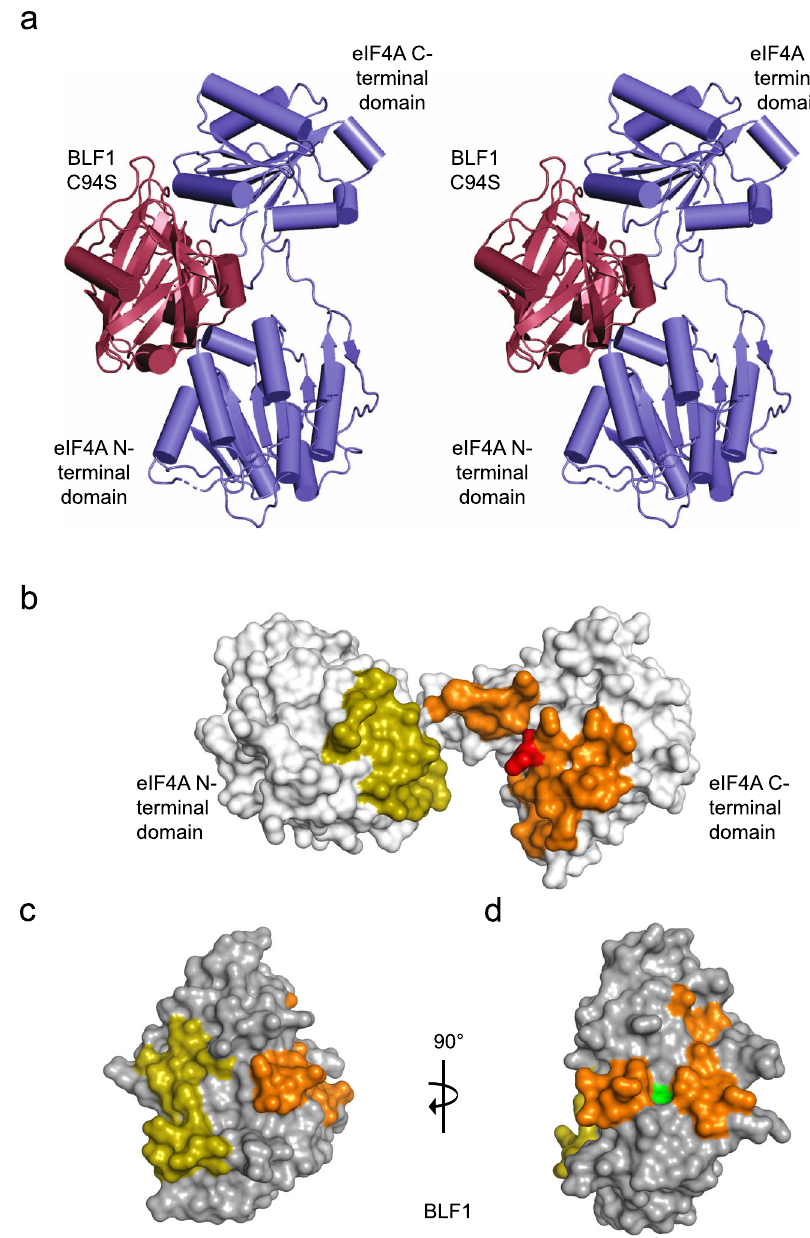
Fig. 1 BLF1 C94S binds in the cleft between the two domains of eIF4A Δ 20 . a Stereo pair for cross-eyed viewing of the structure of the BLF1 C94S:eIF4A Δ 20 complex (PDB:7PQ0 (BLF1; maroon, eIF4A; blue)). b Surface representation of the N- and C-terminal domains of eIF4A. The two patches that interact with BLF1 C94S are shown in gold and orange, respectively with the remainder of the surface colored white. Gln339 of eIF4A is colored red. c Surface representation of the corresponding patches (gold and orange) on BLF1 that interact with eIF4A with the remainder of the surface colored gray. The view is rotated about the horizontal axis by 90° compared to the orientation of eIF4A shown in panel b so that the patches on BLF1 face the reader. d In a second view, modi fi ed by a rotation of 90° around the vertical axis, the surface of BLF1 fl anking the active site is shown with the Cys/His pair colored